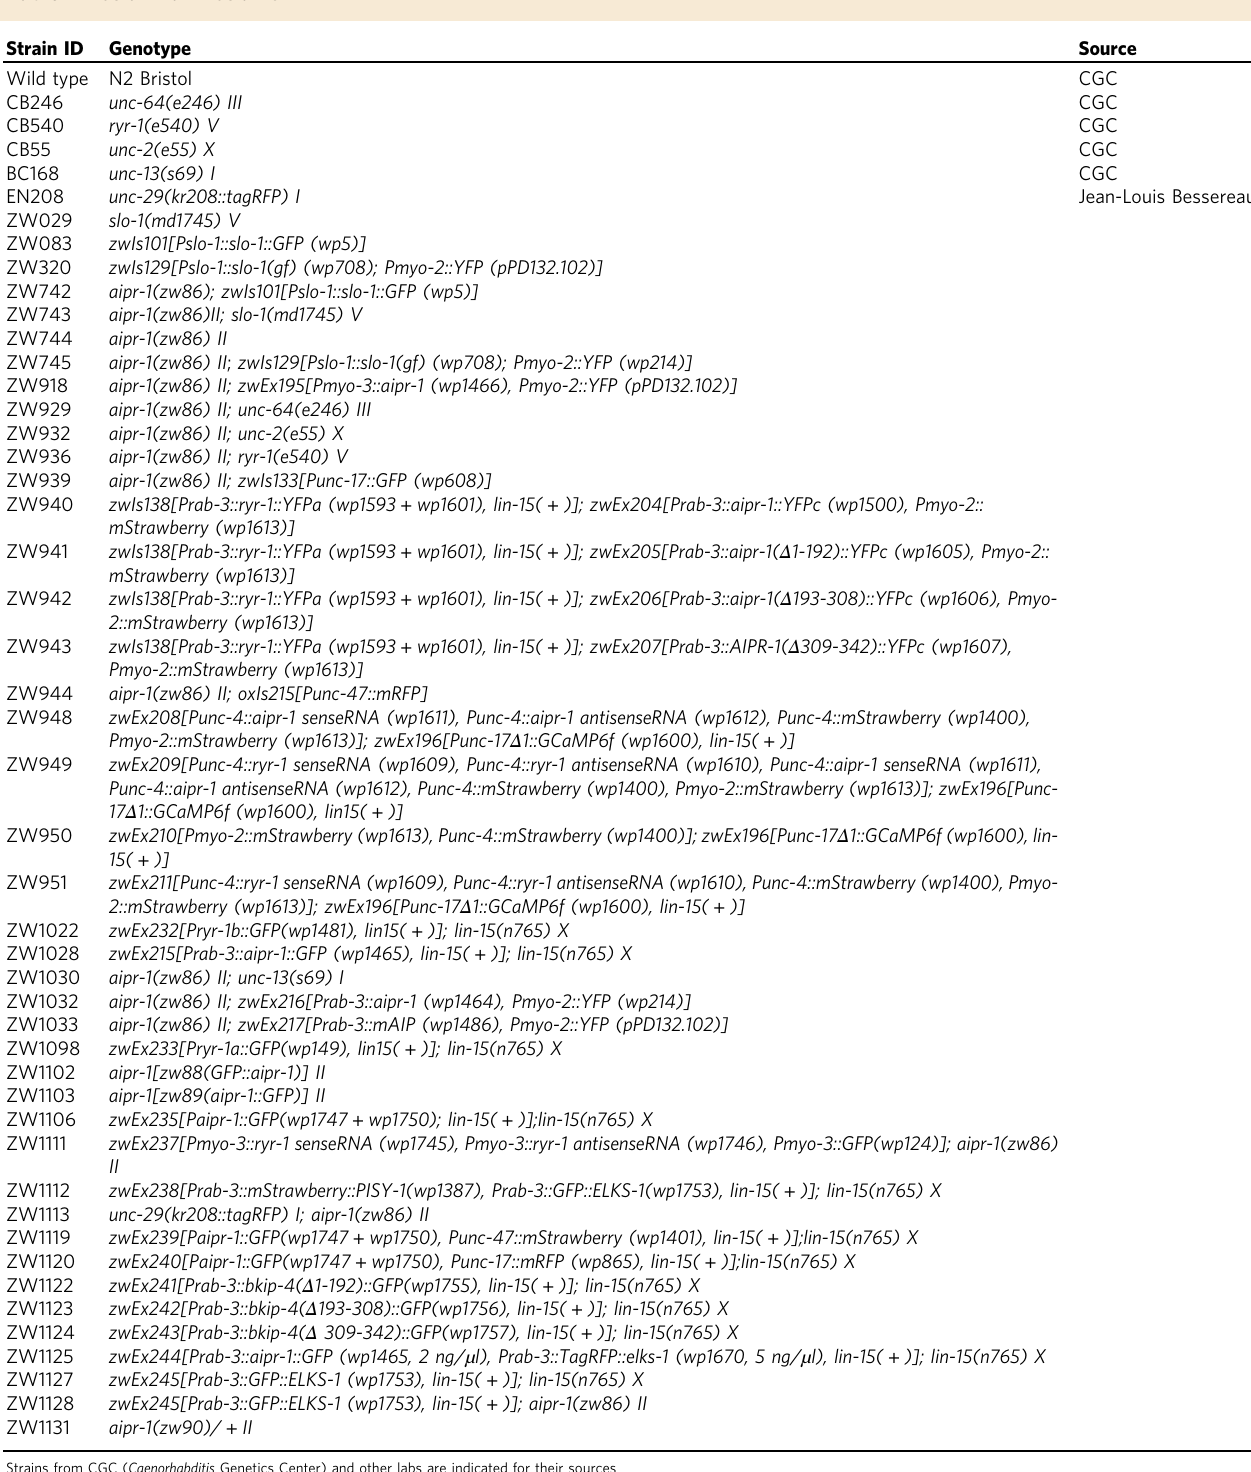
Table 1 List of worm strains Strain